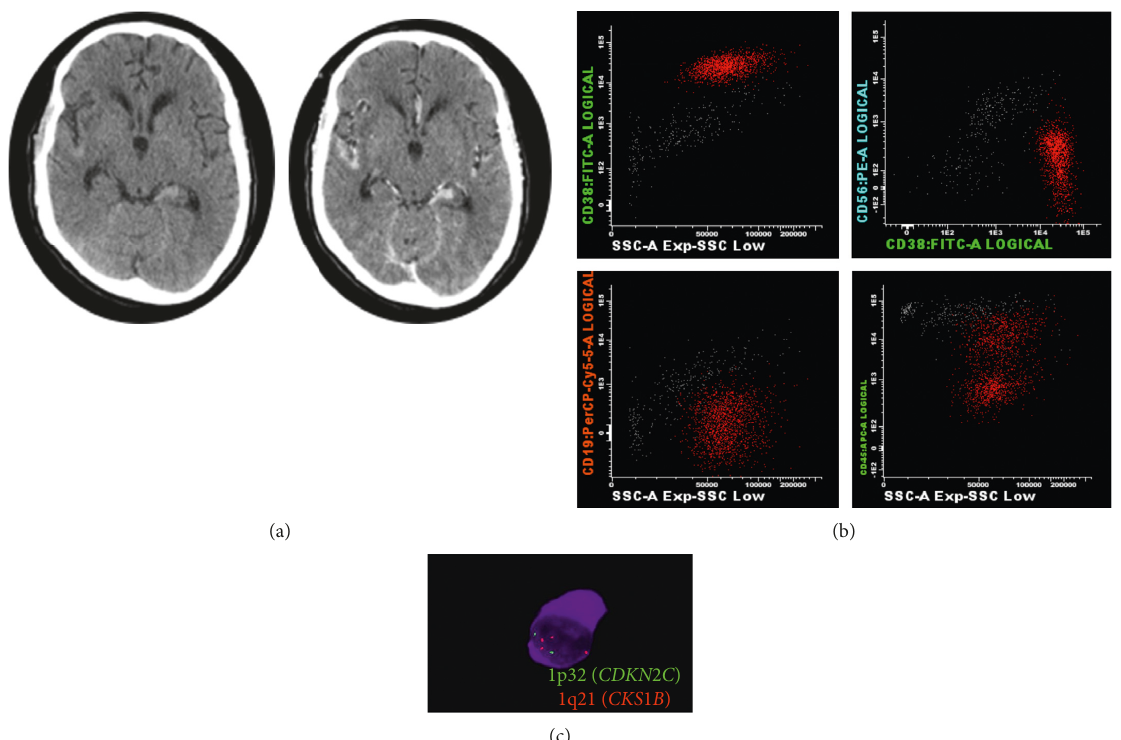
Figure 2: (a) Spontaneous hypodense areas with intense cortical contrast enhancement in bilateral insulae, anterotemporal predominance of the left grooves, engorgement of the left choroid plexus, right cerebellar tent, the right side of the prepontine cistern and pituitary gland, supratentorial ventricular dilatation with transependymal edema, focal area of lower density in the body of sphenoid, and extensive leptomeningeal infiltration. (b) 35 cells (87% neoplastic plasma cells). (c) 1p32/1q21 copy number changes evaluated by FISH: 1p32, green; 1q21, red and 1q21 gain